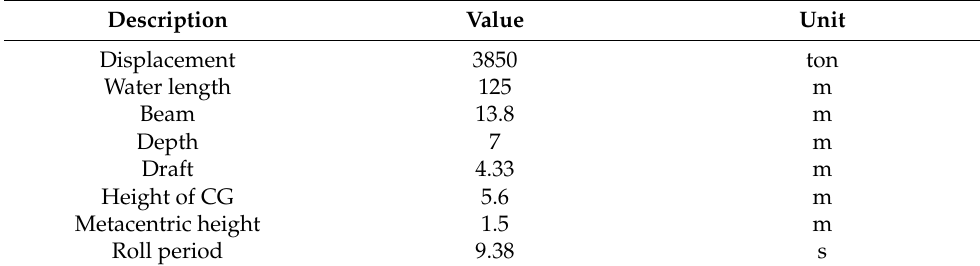
Table 1. Parameters of the ship.